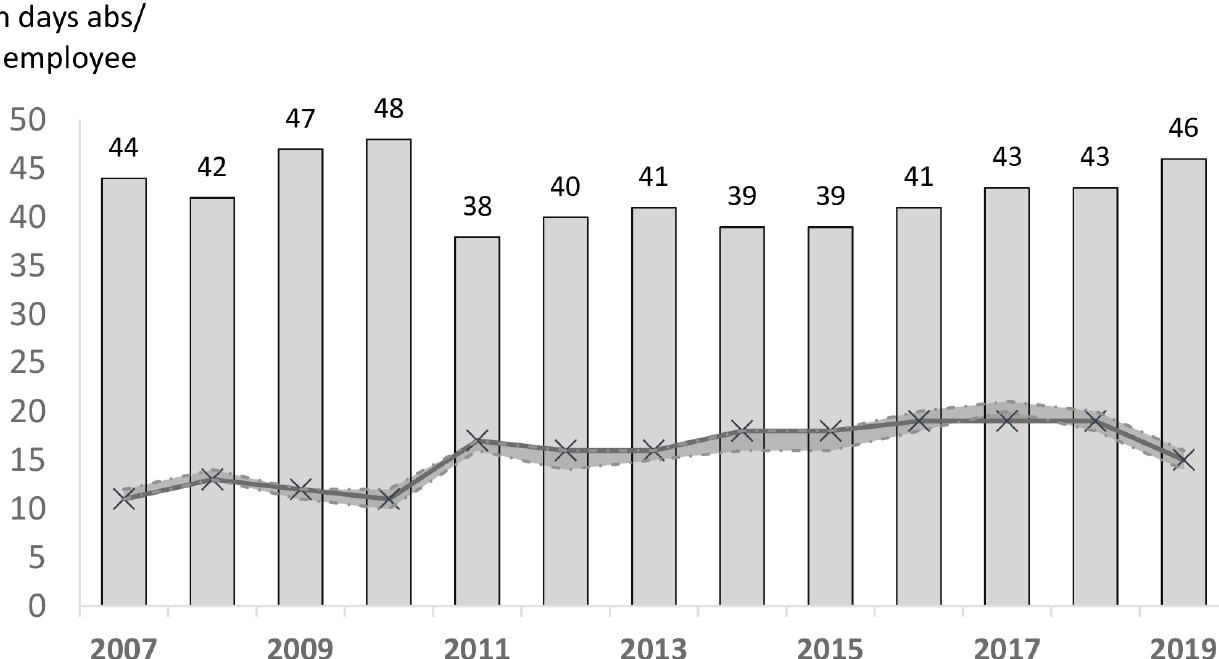
Figure 1. Evolution in the proportion of absentees (the crosses) and the number of days of absence (the bars) per absent employee (expressed in median ± one centile).